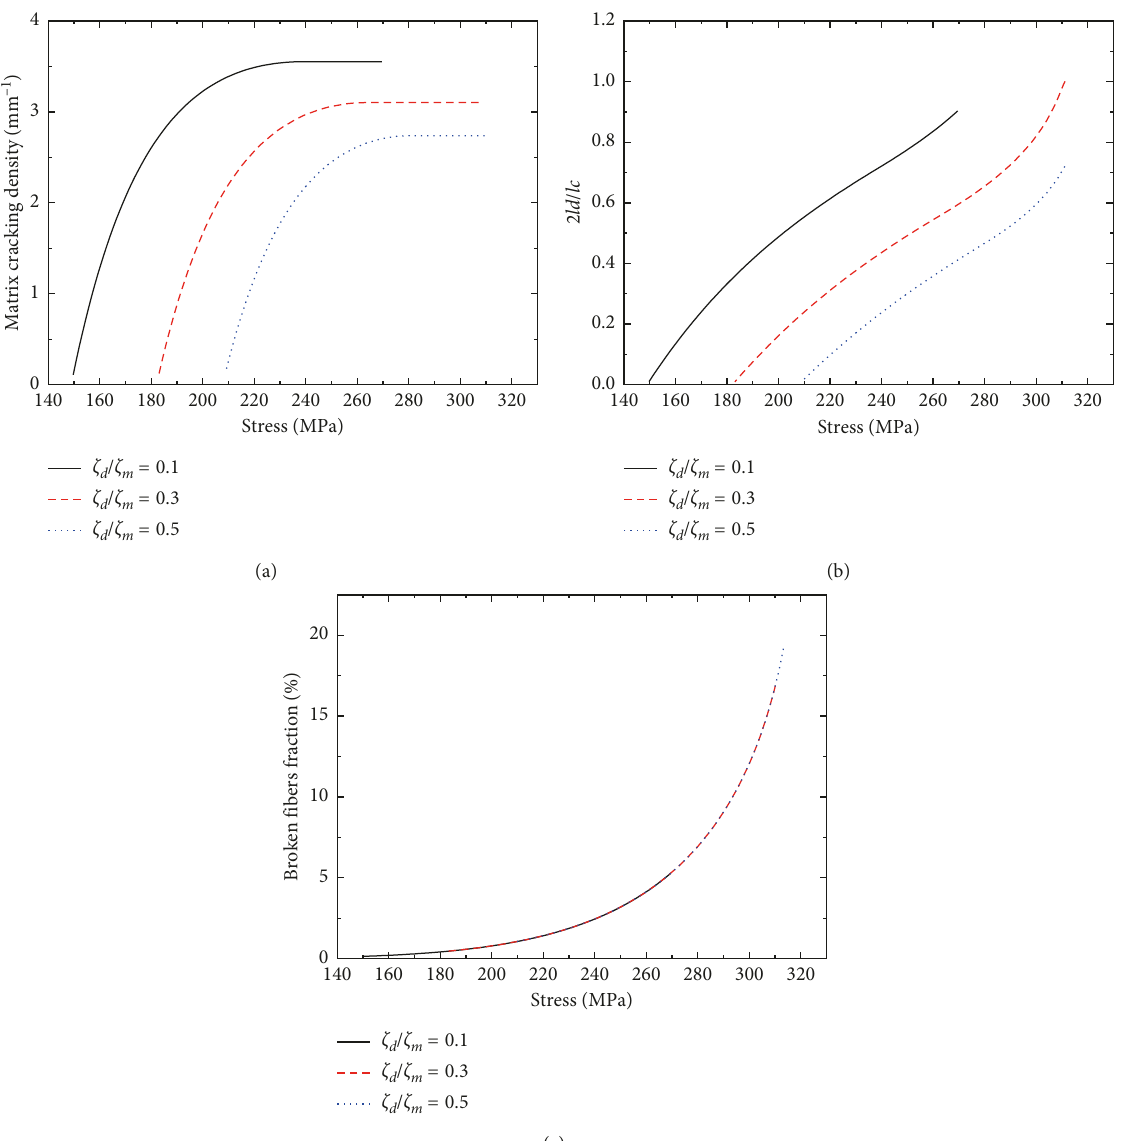
Figure 4: (a) The matrix cracking density versus the applied stress curves; (b) the interface debonding length versus the applied stress curves; (c) the broken fibers fraction versus the applied stress curves for different interface deboned